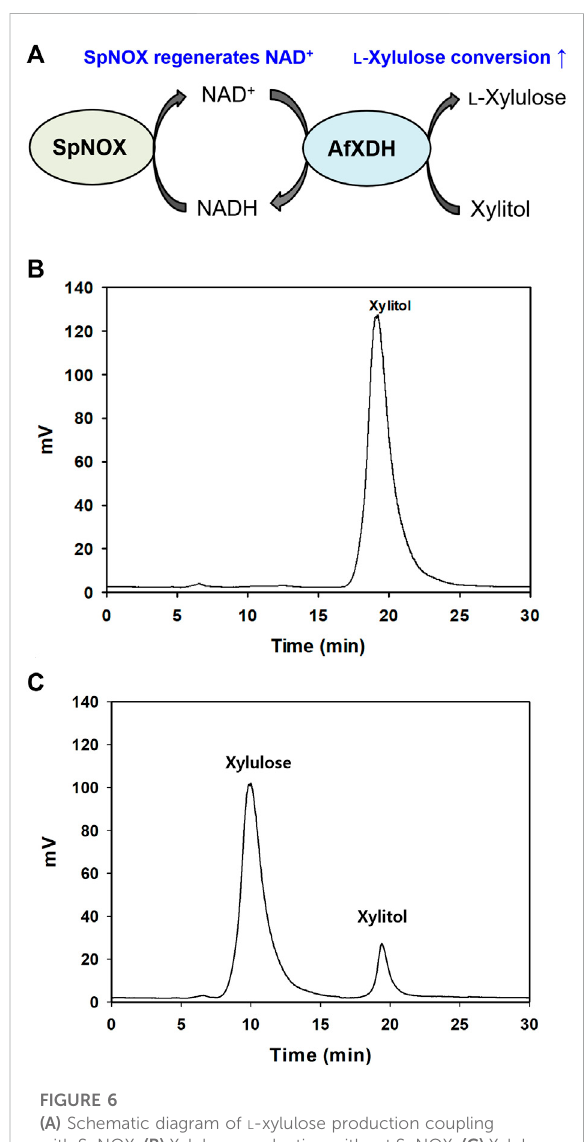
FIGURE 6 (A) Schematic diagram of L -xylulose production coupling with SpNOX. (B) Xylulose production without SpNOX, (C) Xylulose productioncouplingwithSpNOX.Thereactioncontinuedfor12